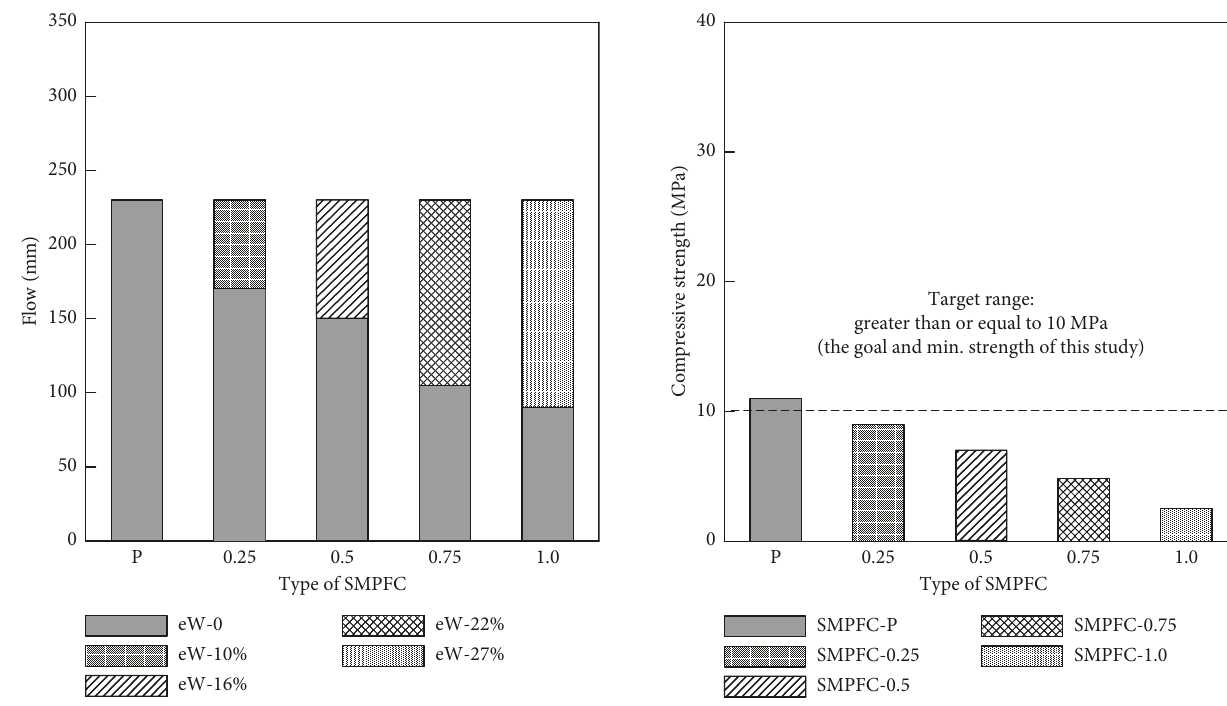
Figure 2: Test results of flow (extra water added).